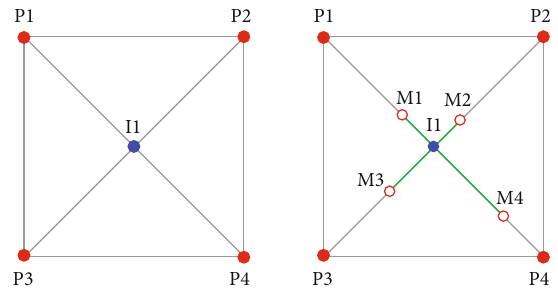
Figure 2: Add imaginary wells to represent the heterogeneously distributed interwell connectivity parameters after pro fi le control